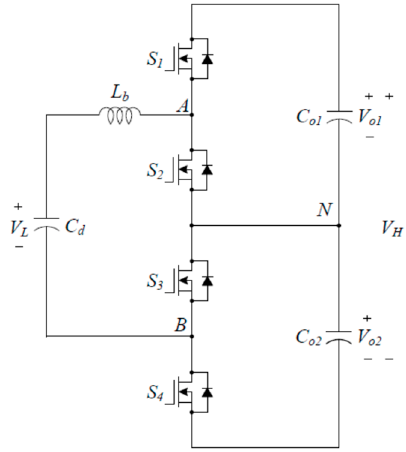
Figure 1. Circuit diagram of the conventional converter.